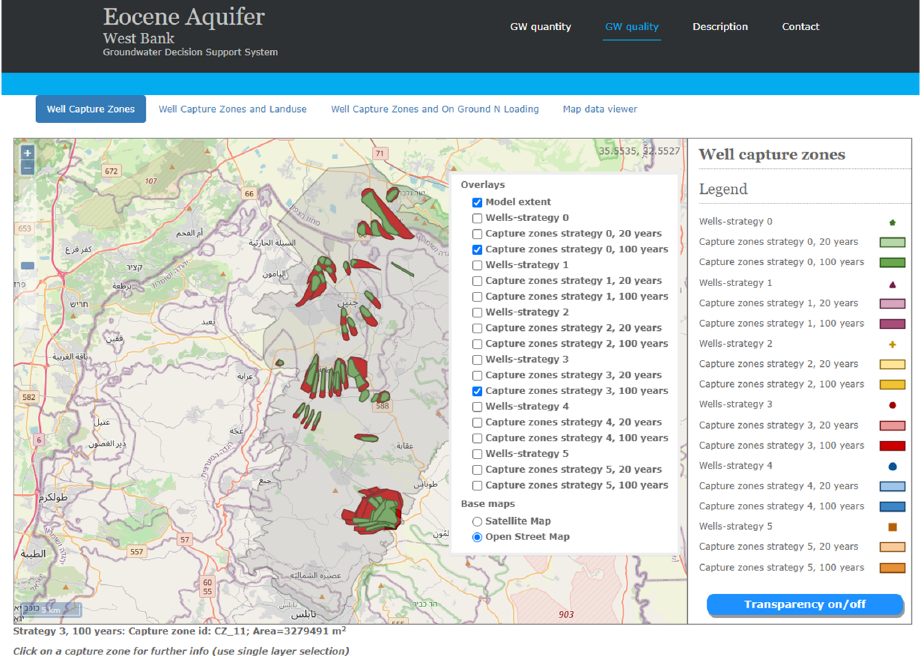
Next, the user interface shows the overlay of the different capture zones with land Figure 30. Wells capture zones for current conditions and for strategy 03. use data, as shown in Figure 31 (example of strategy 5). Clicking inside each land use unit Figure 30. Wells capture zones for current conditions and for strategy 03. within a particular capture zone presents further information below the map interface.